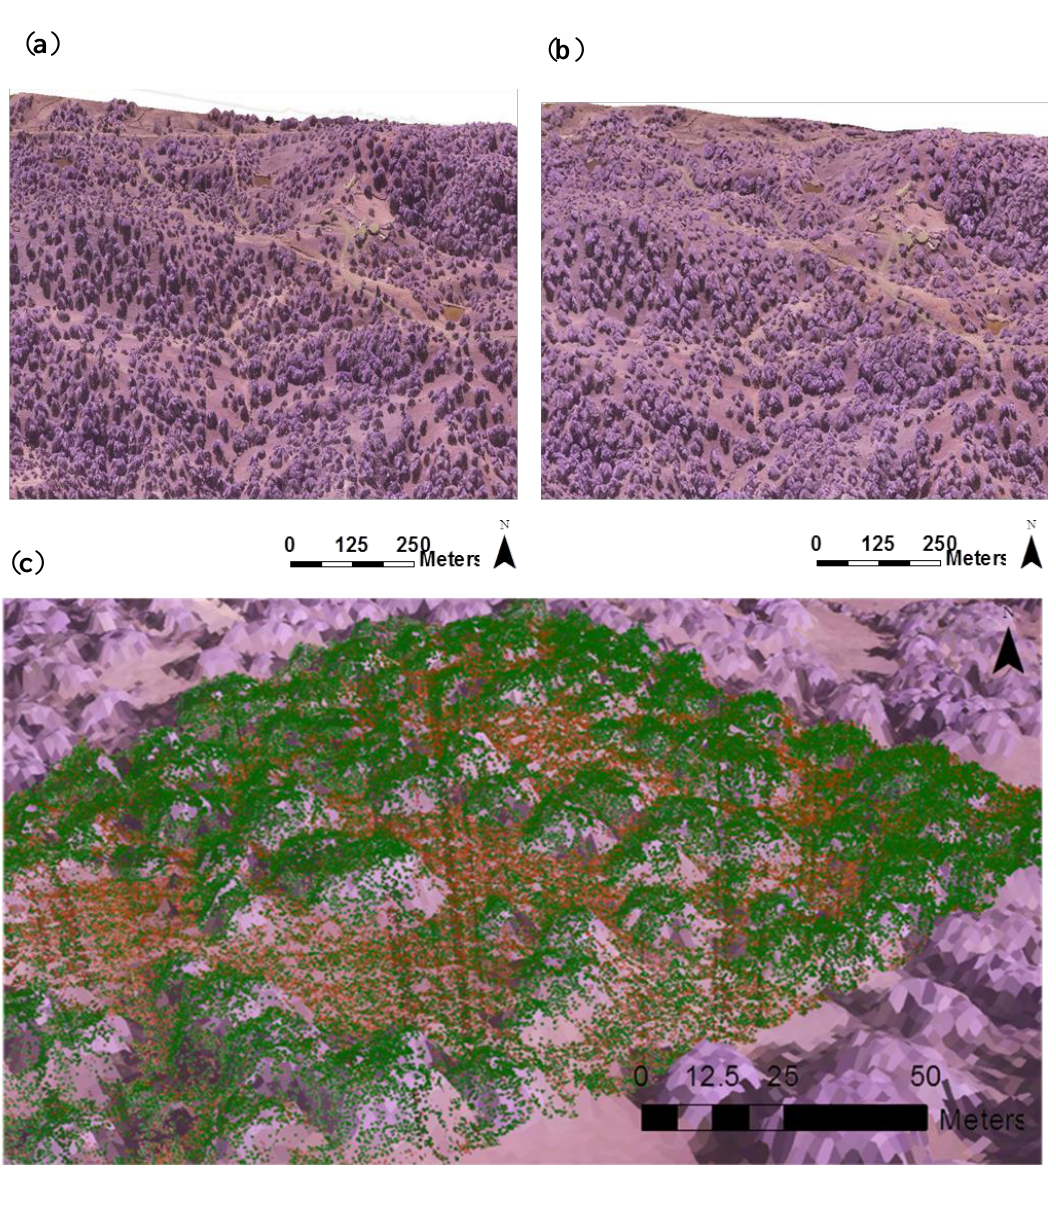
Figure 2. ( a ) Example of the ALS-based canopy height model. ( b ) Digital aerial imagery (DAI)-based canopy height model. ( c ) ALS cloud points overlaid on the DAI-based canopy height